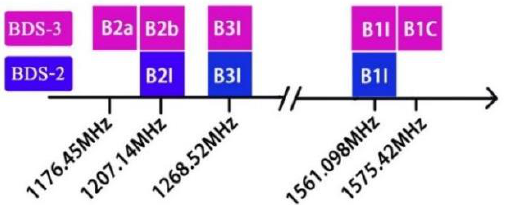
Figure 1. BDS signals in the L band.